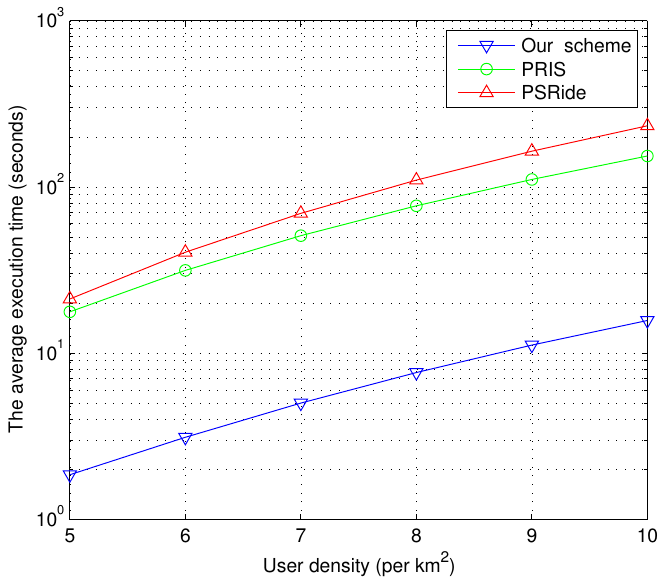
Figure 8. Impact of the user density on execution